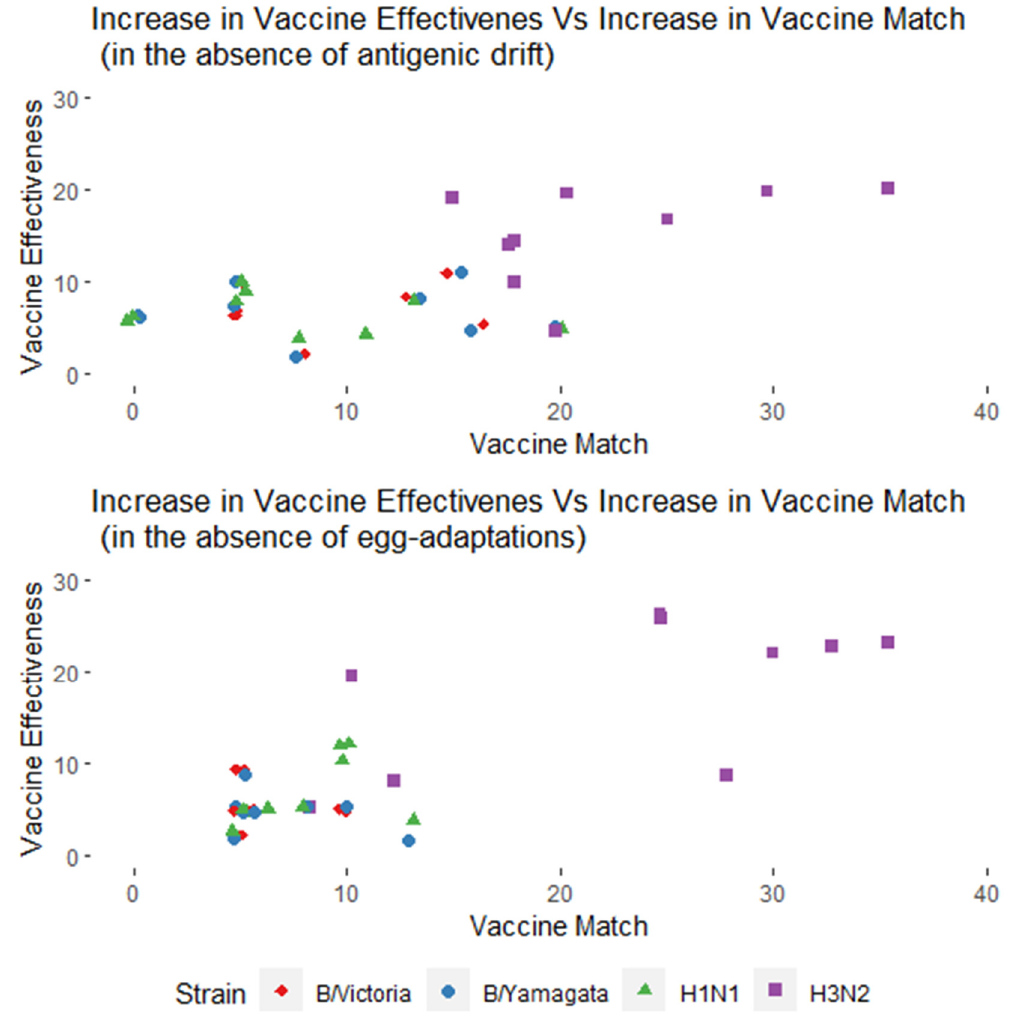
Figure 5. Correlation between vaccine effectiveness and vaccine match in the experts’ responses.